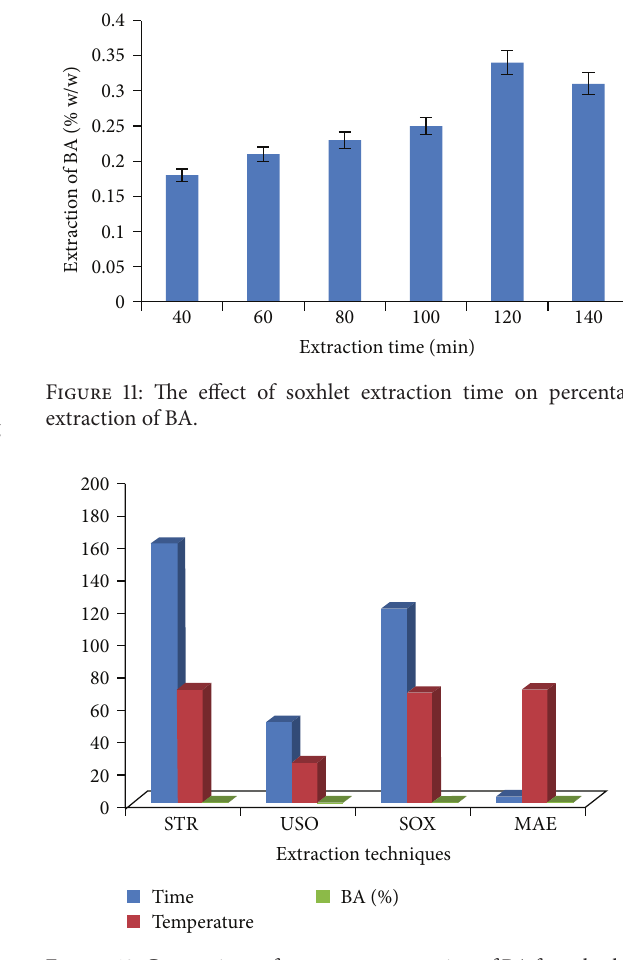
Figure 12: Comparison of percentage extraction of BA from bark of Z. jujubae by different extraction